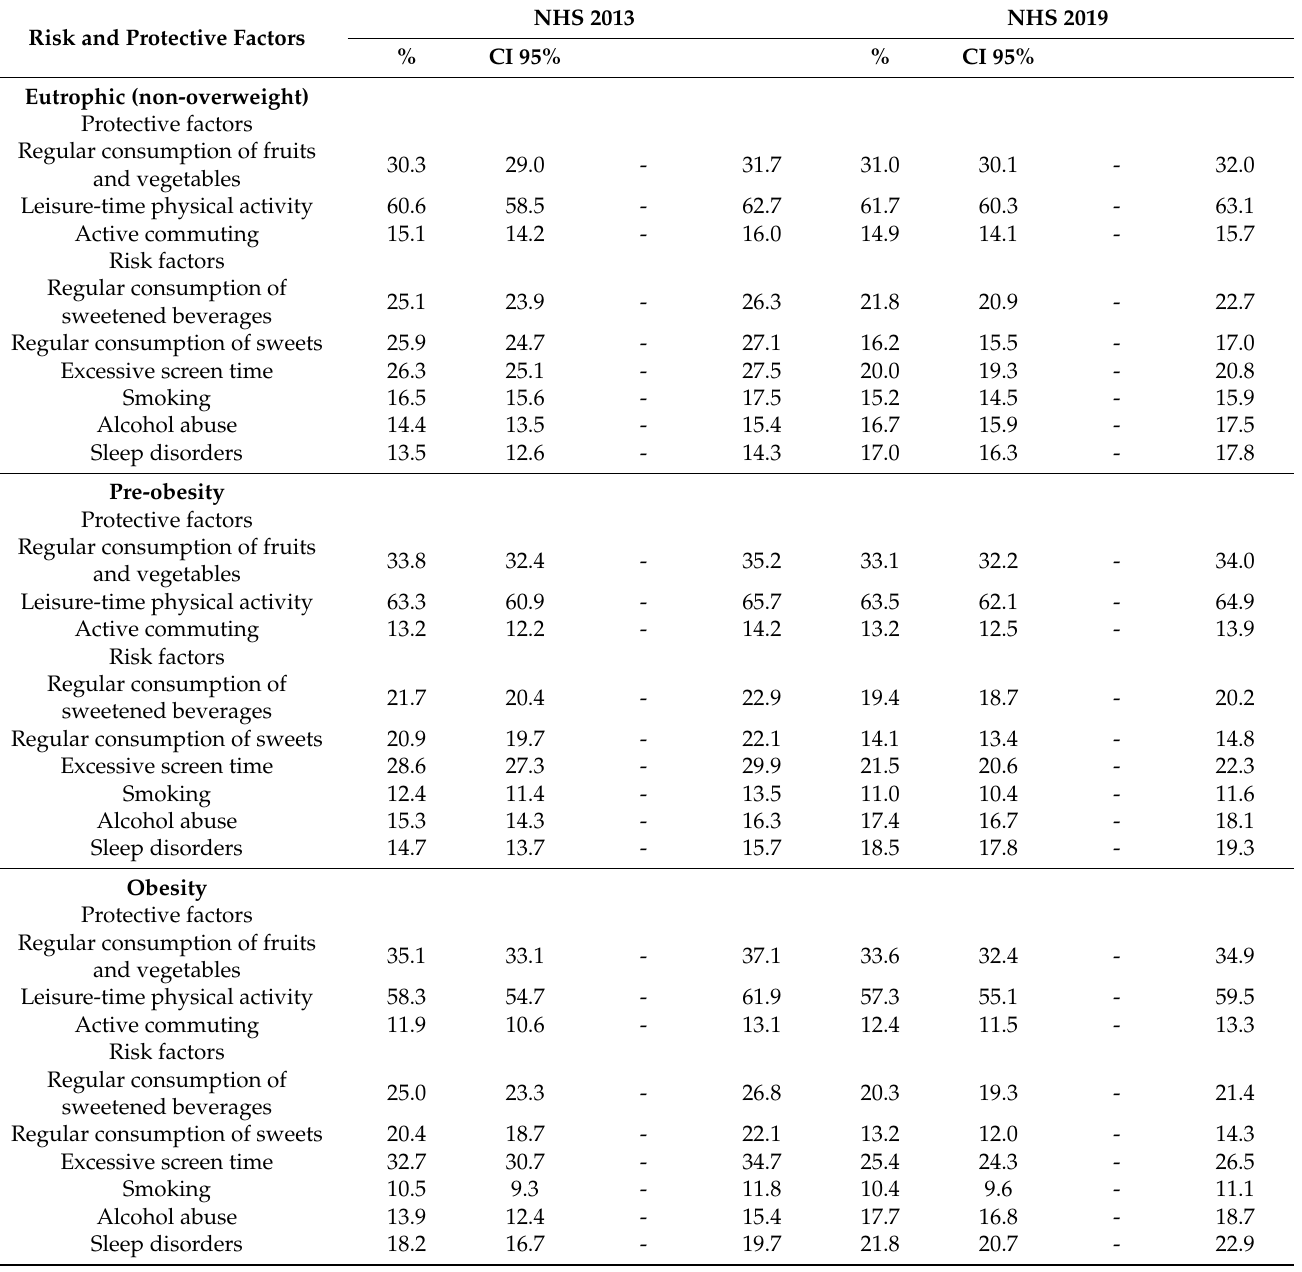
Table 2. Distribution (%) of risk and protective factors according to nutritional status of